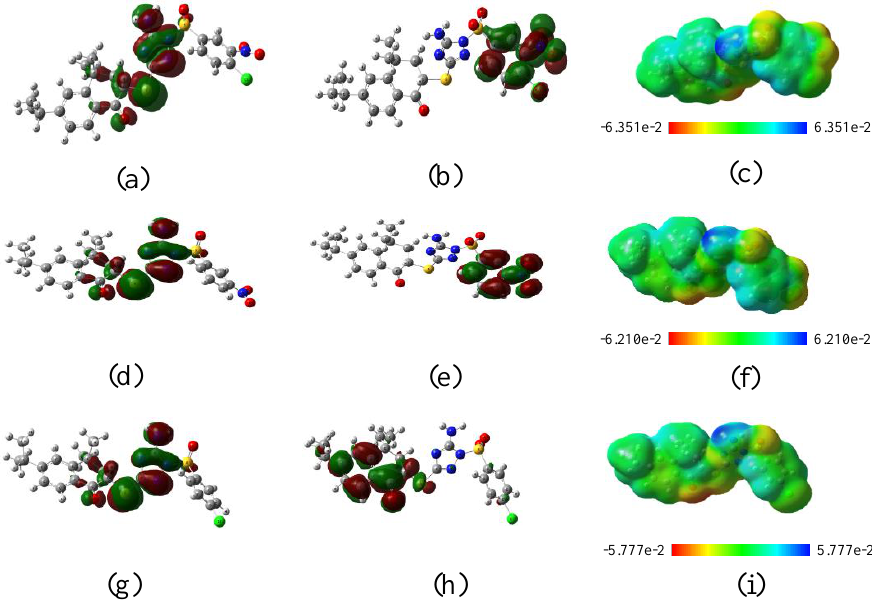
Figure 2. Frontier molecular orbitals and ESPs of compounds 6h : HOMO ( a ), LUMO ( b ), and ESP ( c ); 6k : HOMO ( d ), LUMO ( e ), and ESP ( f ); 6j : HOMO ( g ), LUMO ( h ), and ESP ( i ).